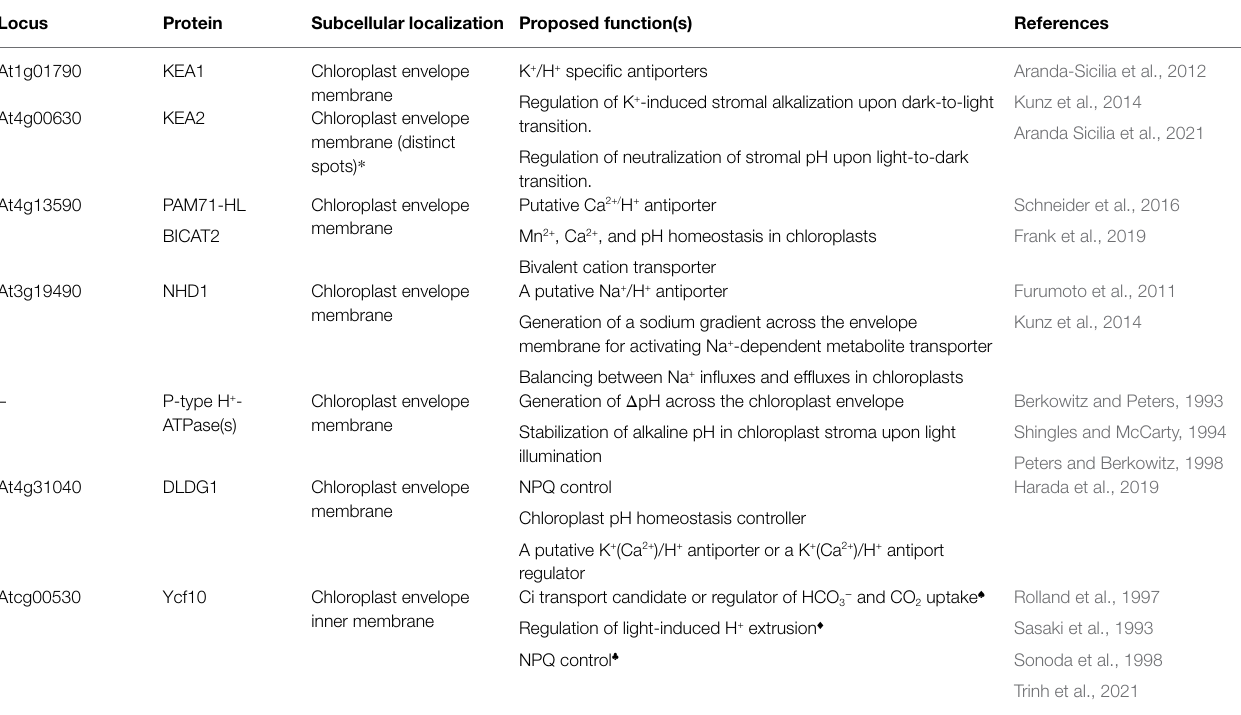
TABLE 2 | Proton-involved transporters and protein factors regulate chloroplast stromal pH.